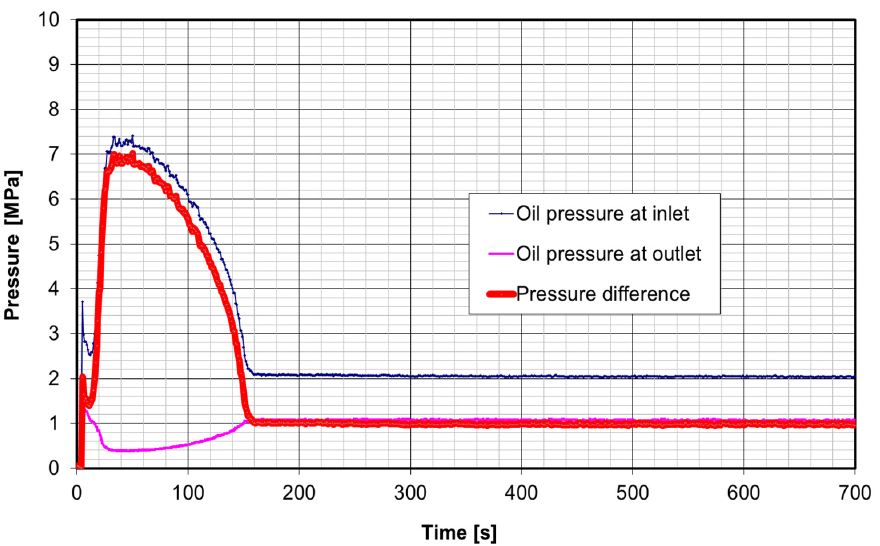
Figure 14. Characteristics of the oil pressure at the inlet and the outlet of the motor and their difference as a function of time (ambient temperature (motor) − 20 °C, oil temperature 50 °C, obtained rotational speed of about 255 rpm).